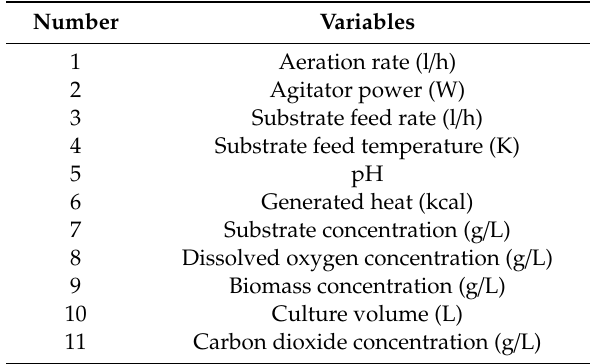
Table 4. Variables selected for monitoring in penicillin fermentation case.